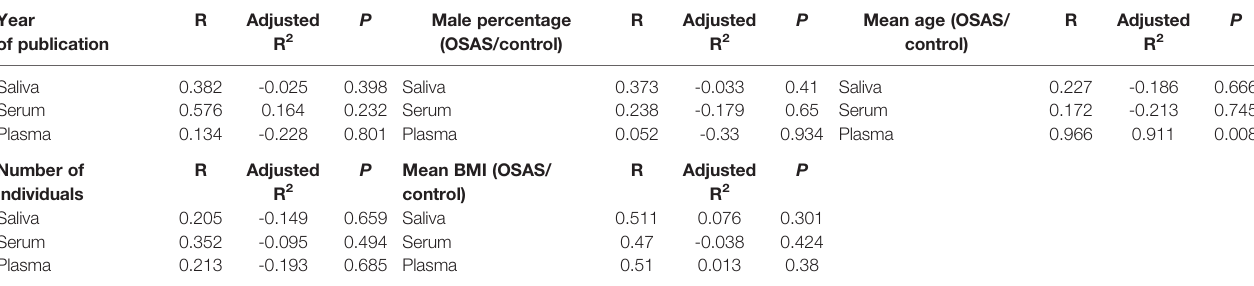
TABLE 4 | Meta-regression analysis, based on several variables [year of publication, number of individuals, male percentage, mean body mass index (BMI), mean age], for salivary, serum, and plasma levels of cortisol in adult obstructive sleep apnea syndrome patients compared to controls. Year of